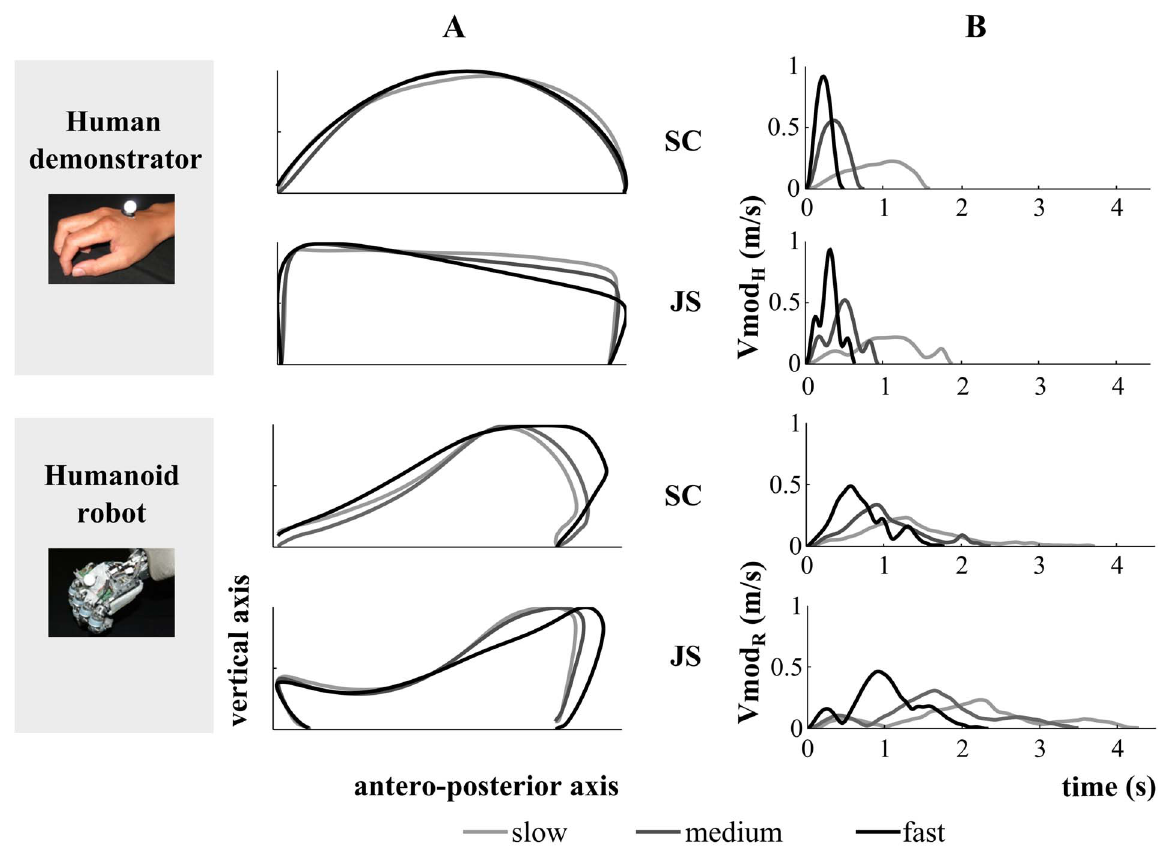
Figure 2. Examples of trajectories and velocity profiles when the demonstrators performed a biological movement. On the left, are represented the human and the humanoid demonstrators’ trajectories in the sagittal plane; on the right, the modules of the velocity profile of the two stimuli. SC and JS refer to smooth-curvilinear and jerky-segmented trajectories, respectively. The levels of grey code movement velocities.